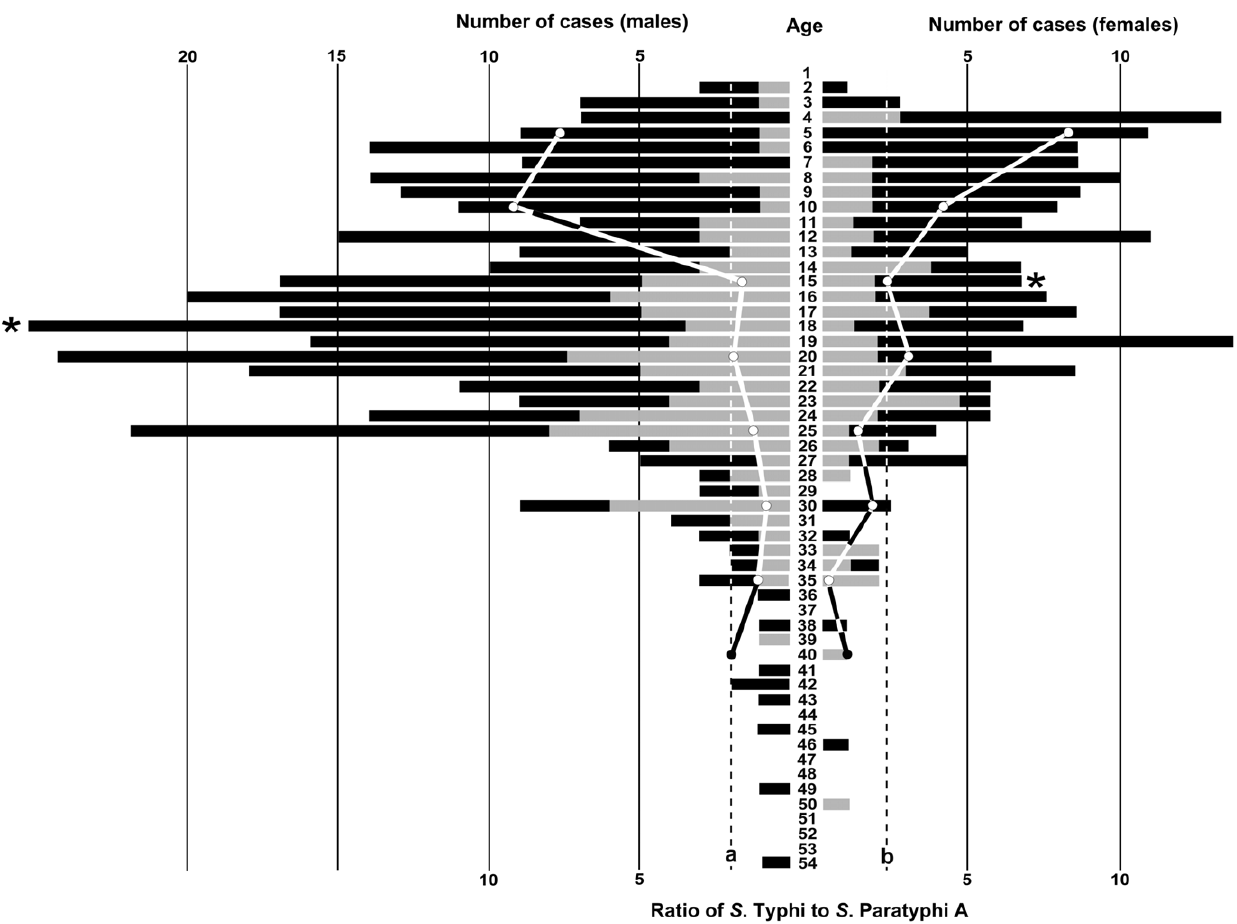
Figure 4. The age distribution of a subset of enteric fever cases at Patan Hospital, LSMC. A double sided bar chart showing the age distribution (central scale; y axis) of blood culture positive enteric fever cases enrolled in clinical trials at Patan Hospital in LSMC between June 2005 and May 2009 (n=527). Bar sizes correspond to the number of patients (upper x axis) of each sex (left; male and right; female). Cases that were culture positive for S . Typhi are shown in dark shading, those that were culture positive for S . Paratyphi A are shown in light shading. The ratio of culture positive S . Typhi to S . Paratyphi A cases over the period of investigation in each five year age group for males and females are shown by the solid lines with solid circles (lower x axis). The overall ratio of S. Typhi to S . Paratyphi A was 2.69:1 in males (shown by the black broken line a) and 2.73:1 in females (shown by the black broken line b). The median age of the male and female patients is shown by the asterisk.